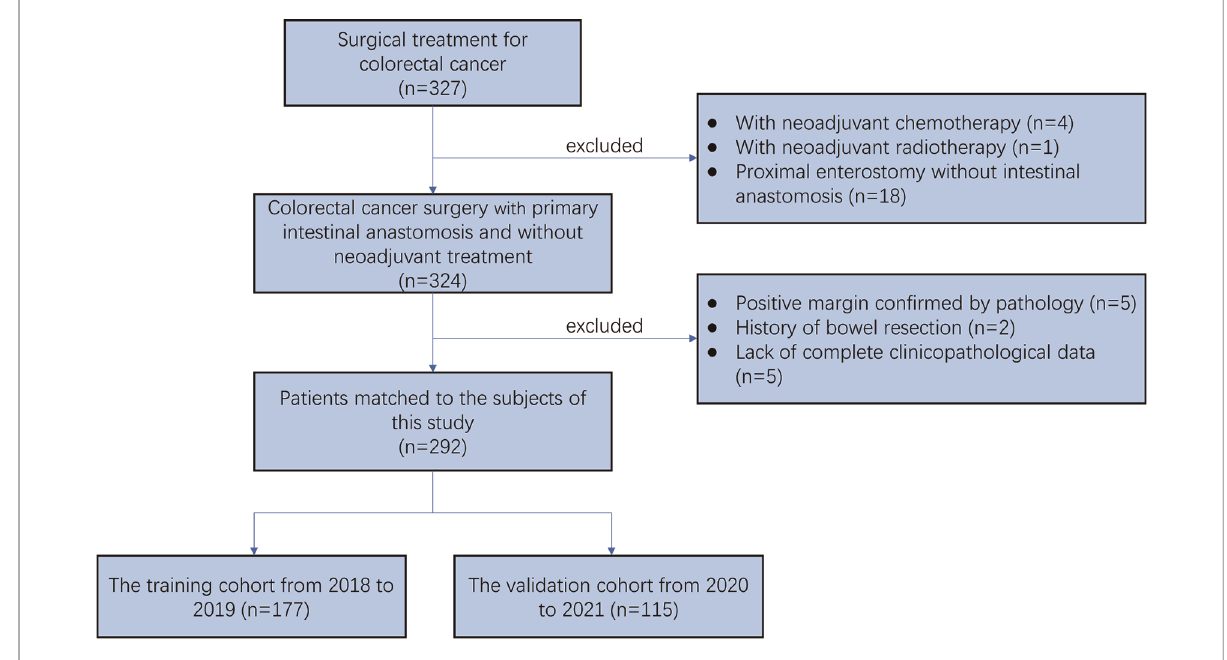
FIGURE 2 The fl ow chart of the selection process for the colorectal cancer patients from from January 2018 to October